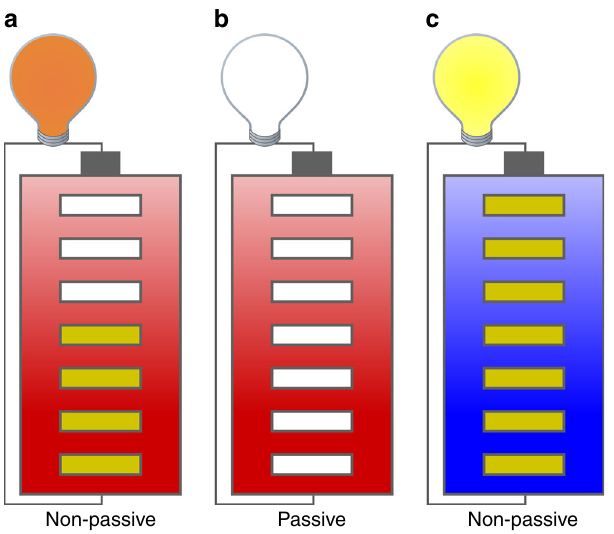
Fig. 1 Visualisation of the concept of passive energy and ergotropy. The different kinds of energy contained in a quantum state visualised by means of a battery at a certain temperature. The battery charge (yellow bars) represents ergotropy W (extractable as work, here illustrated by a lighted bulb) and its temperature (colour of the battery: red — hot, blue — cold) represents passive (here: thermal) energy E pas — the higher the temperature the larger the passive energy. a The battery is partly charged and hot: this represents a non-passive state that allows for work extraction. As the battery is not completely charged, the light bulb appears dim. b The battery is discharged, but its temperature is the same as in a . This state is the passive state of a and, consequently, the light bulb does not shine. c The battery is in a non-passive state whose ergotropy is higher than in a (the battery is fully charged) but the passive energy is lower (the battery is colder). Although the total energy in a , c may be the same, more work can be extracted from the state c , causing the light bulb to shine brighter than in a